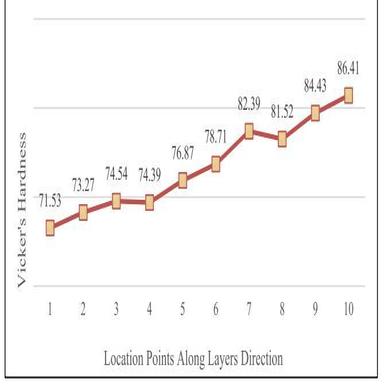
Hardness of FGM along the thickness.